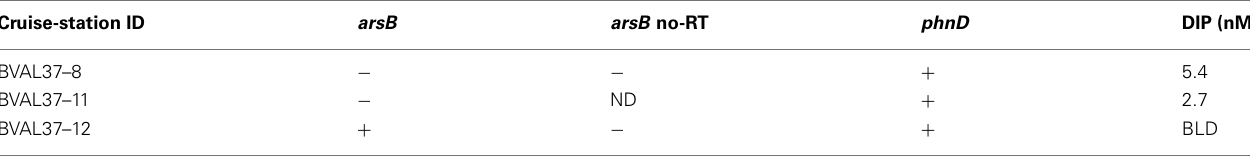
Table 2 | Presence or absence of Crocosphaera watsonii arsB , arsB no-RT, and Synechococcus spp. phnD in field samples. Cruise-station ID arsB arsB